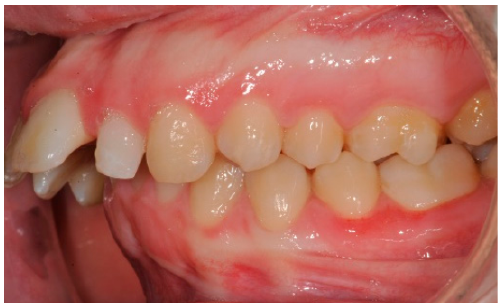
Figure 4. Left buccal segments relationship.